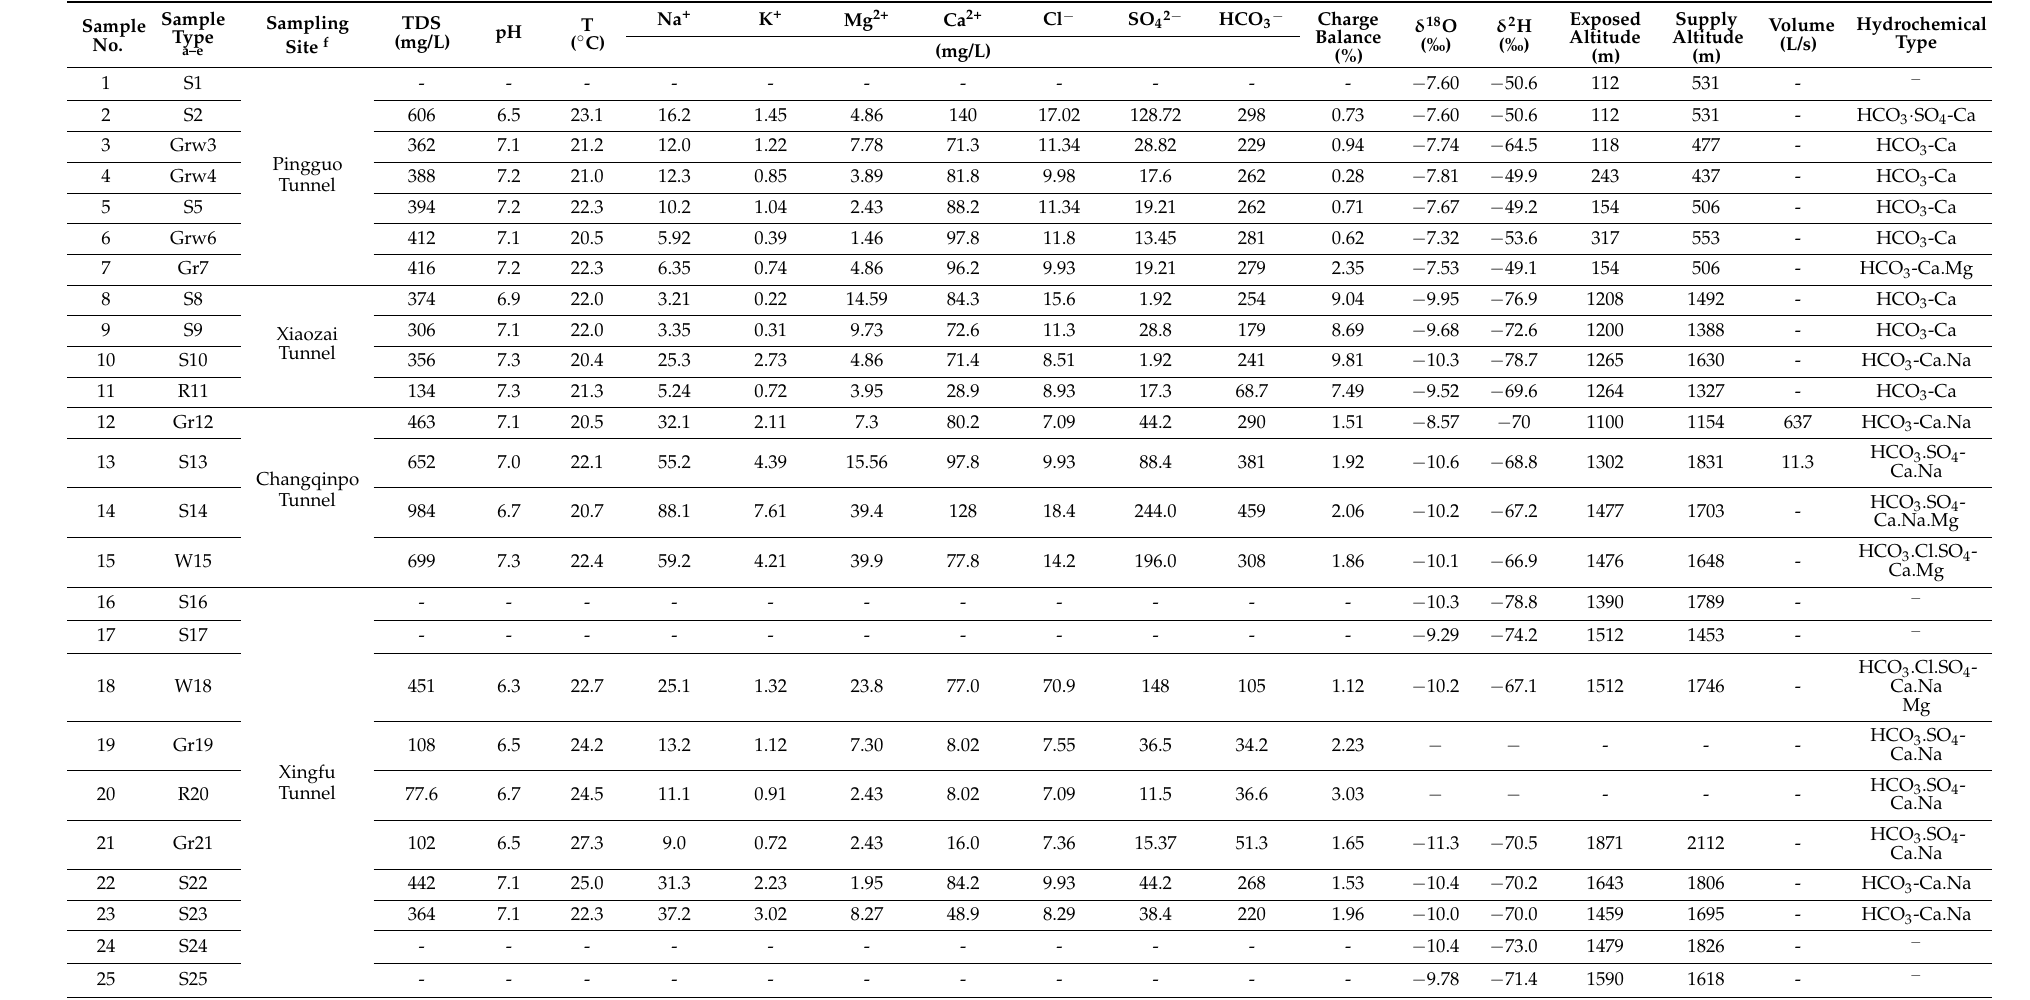
Table 1. Chemical and isotopic compositions of water samples in the study area where railways